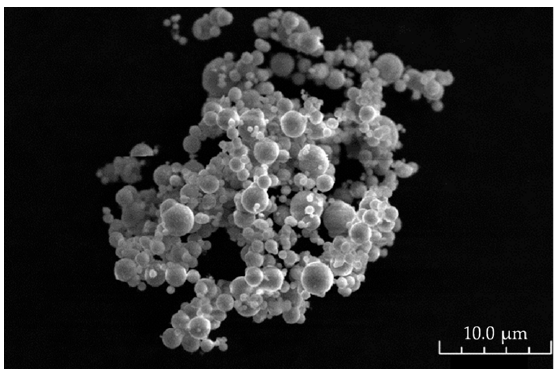
Figure 6. Scanning electron microscopy micrograph of CIP.